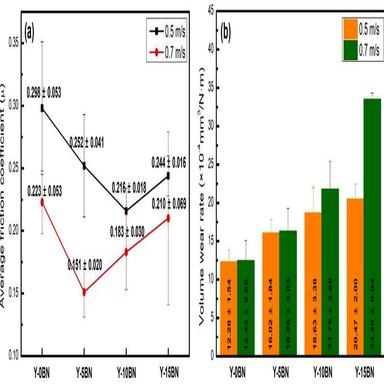
Average friction coefficients (a) and the volume wear rates (b) of the Yb2Si2O7-based coatings with different hBN contents under different linear speeds.